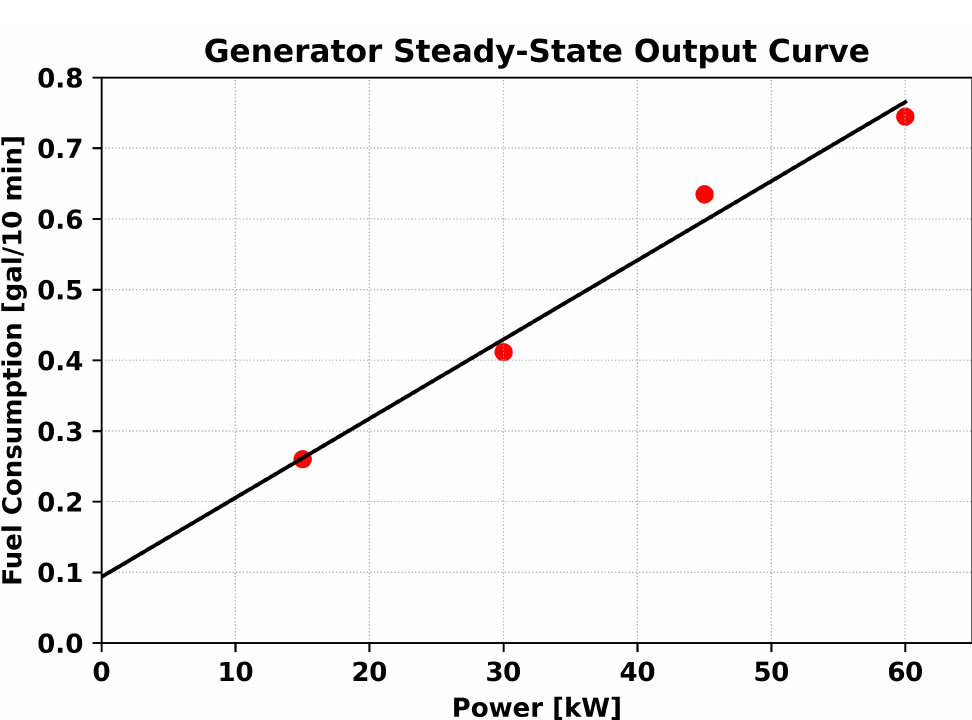
Figure 3. Fuel consumption of a 60 kW AMMPS generator with a linear fit based on generator steady-state power output